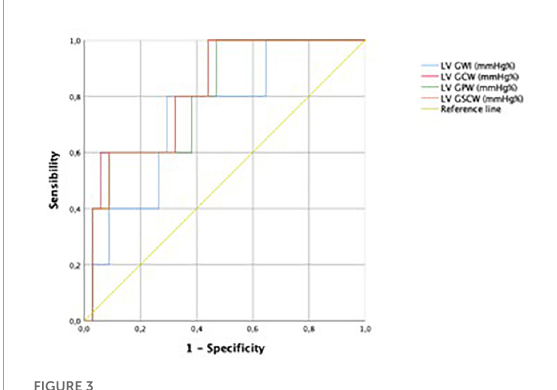
FIGURE3 Receiver operating characteristic curves for predictive performance of LVGWI, LVGCW, LVGPW, and LVGSCW for LVSWI. LVGWI, left ventricular global work index; LVGCW, left ventricular global constructive work; LVGPW, left ventricular global positive work; LVGSCW, left ventricular global systolic constructive work; LVSWI, left ventricular stroke work index. FIGURE4